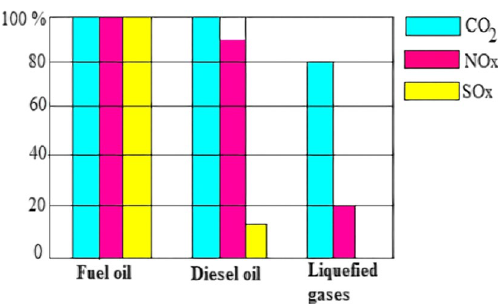
Fig. 2 Pollutant emissions from naval engines (Grosan